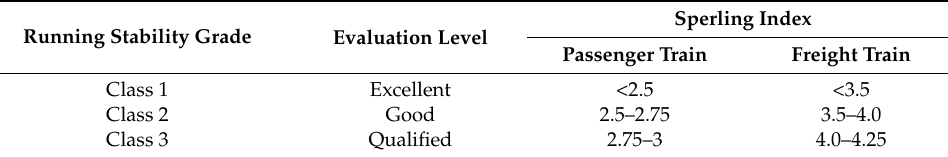
Table 6. The running stability grade of vehicles in China [29].